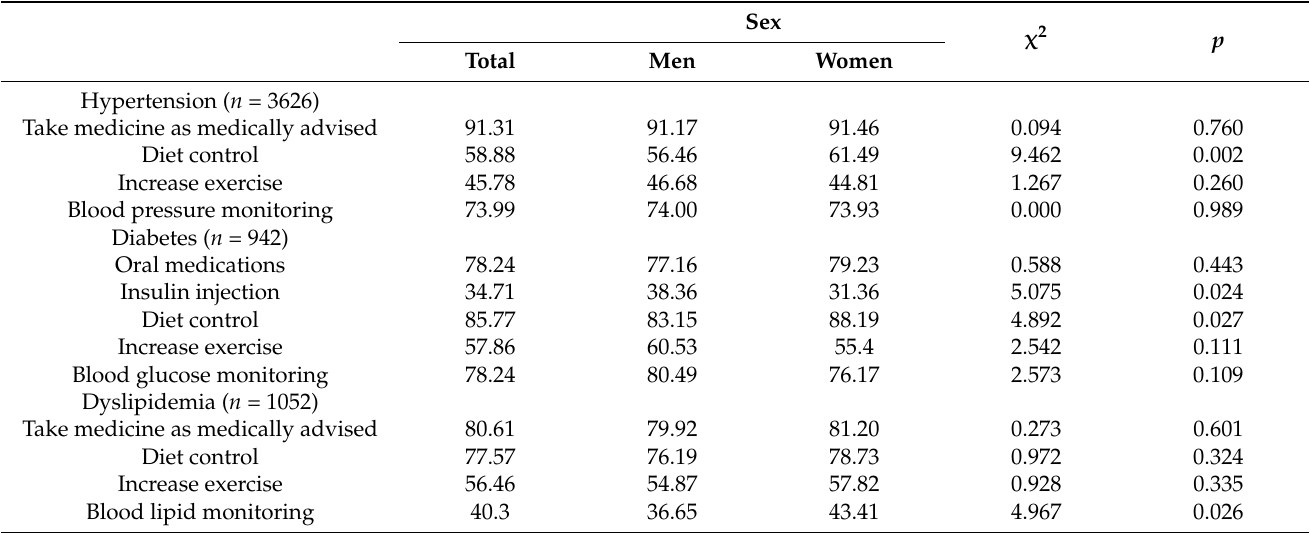
Table 4. Medication adherence and other methods to control risk factors of stroke in Chinese stroke patients with hypertension, diabetes, or dyslipidemia